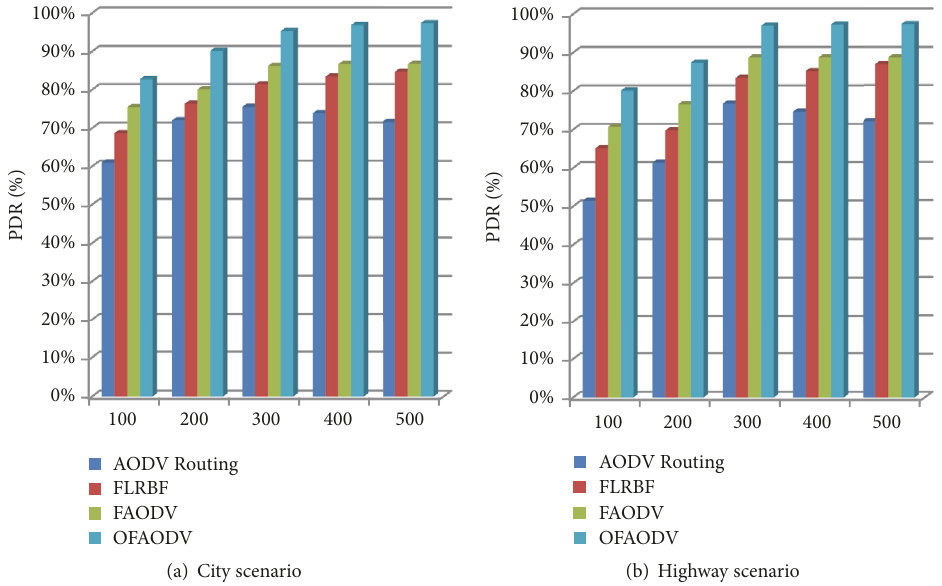
Figure 5: Packet delivery ratio (%) vs. no. of vehicles.